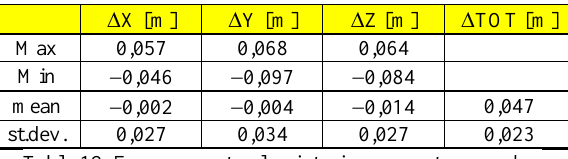
Table 12. Errors on natural points: images vs topography.